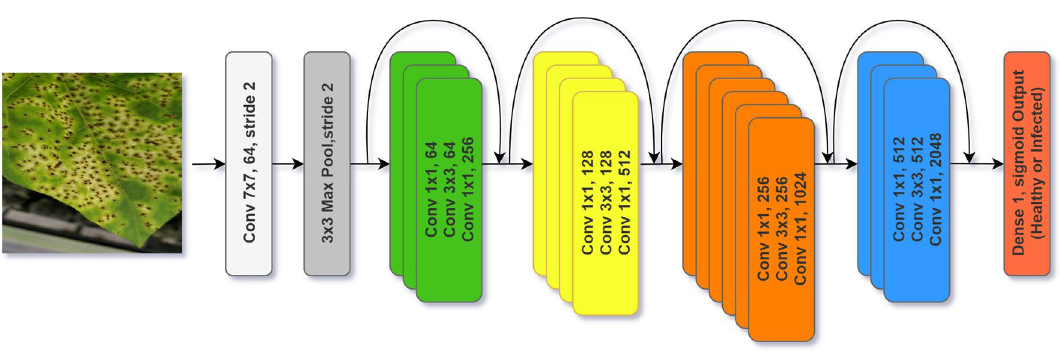
Figure 5. Residual networks (ResNet-50) architecture with a sample input image and 16 residual